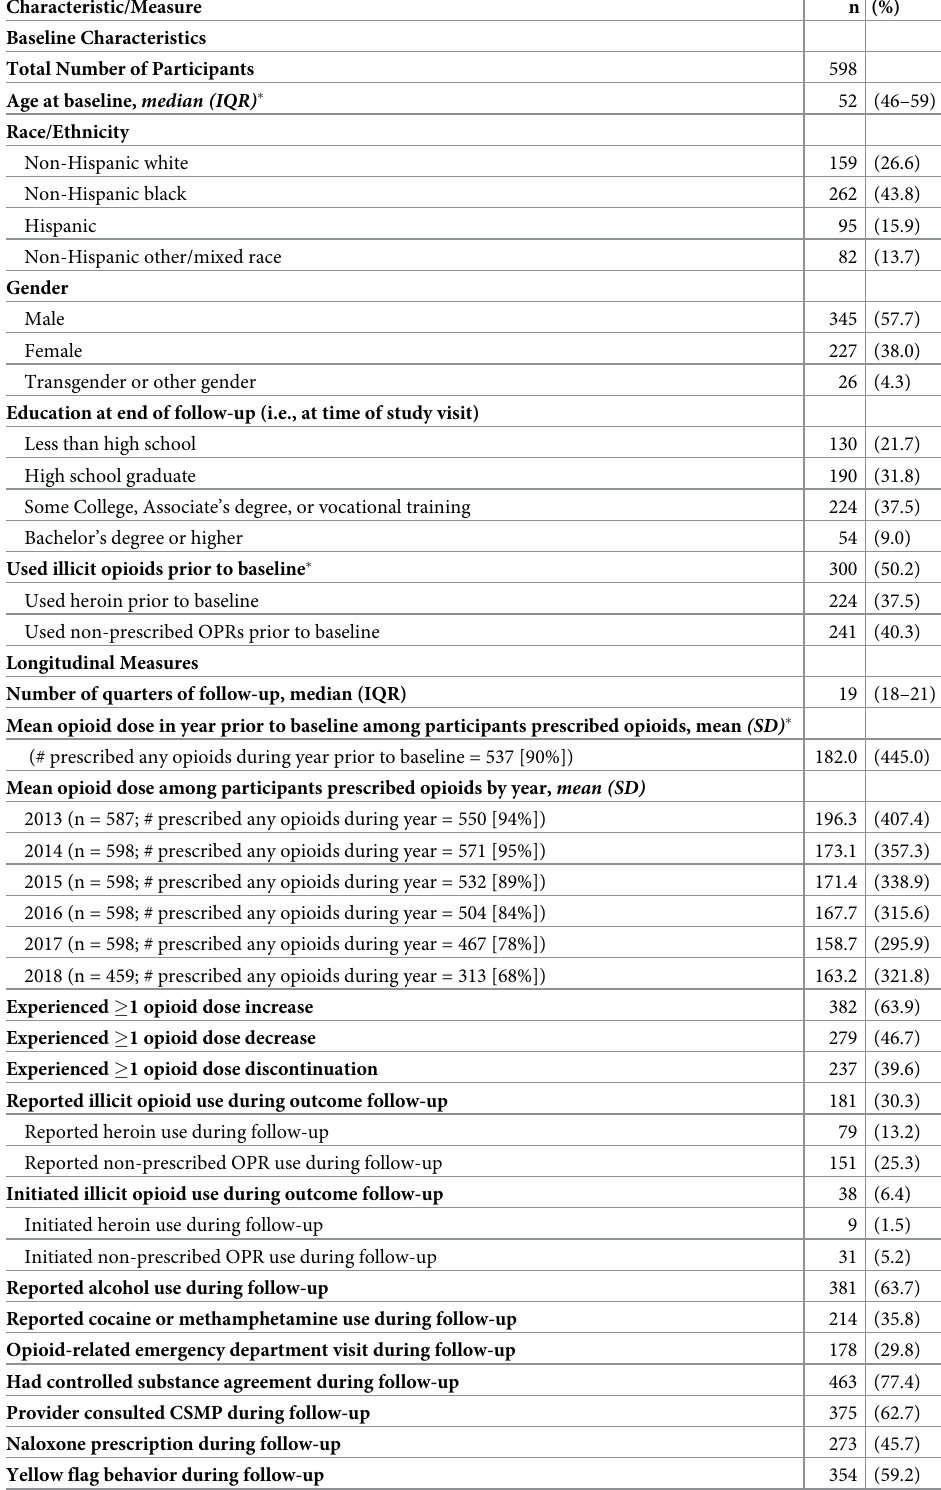
Table 1. Participant baseline characteristics and longitudinal measures (n =